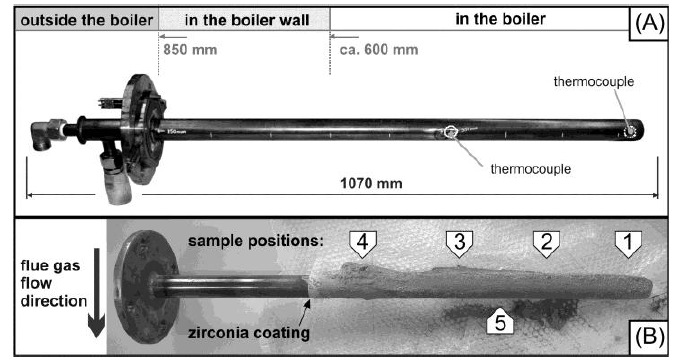
Figure 1. ( A ) Layout of an uncoated test probe for in situ experiments; ( B ) Test probe TP 1 after 14 days in a waste-to-energy (WTE) plant. Positions 1–4: flue gas-facing side (luv), position 5: flue gas-away side (lee).